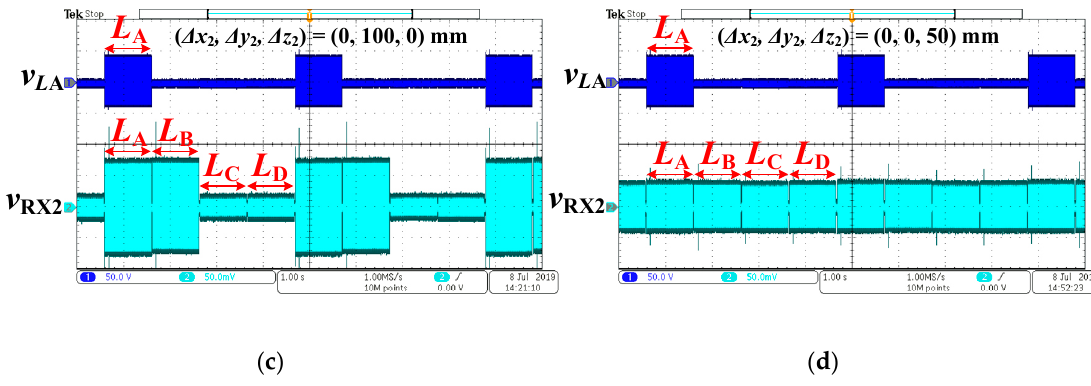
Figure 16. Receiving voltage waveforms when the position change of secondary power coil ( Δ x 2 , Δ y 2 , Δ z 2 ) is equal to: ( a ) (0, 0, 0) mm; ( b ) (100, 0, 0) mm; ( c ) (0, 100, 0) mm; and ( d ) (0, 0, 50) mm.